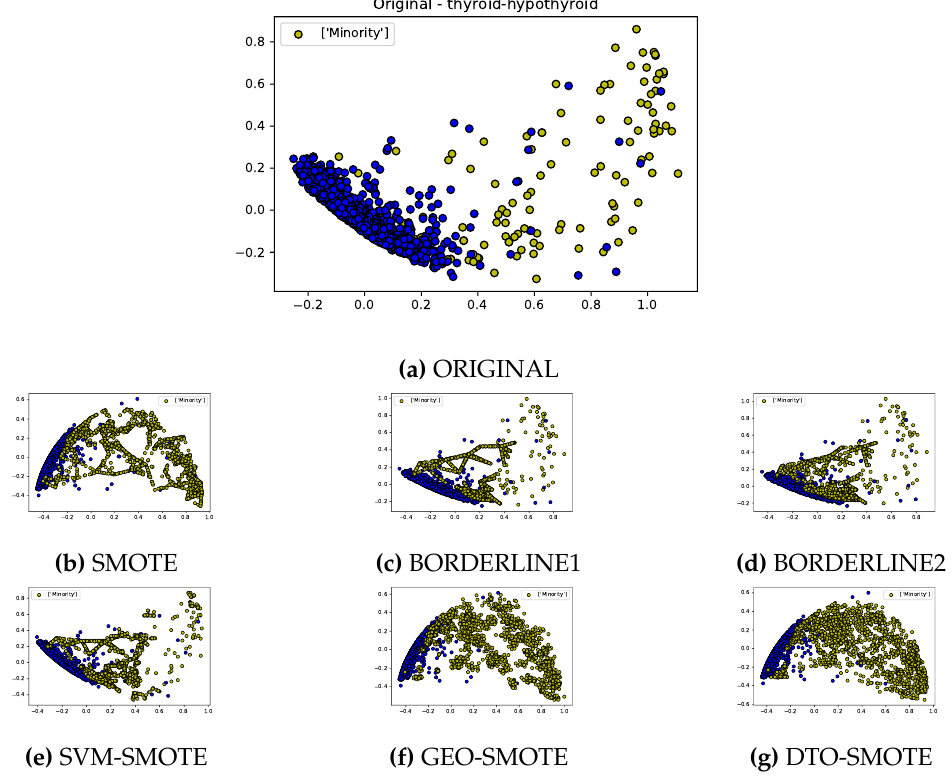
Figure 2. SMOTE Trail Path Patterns - thyroid-hypothyroid data set Figure 2. SMOTE trail path patterns, thyroid-hypothyroid data